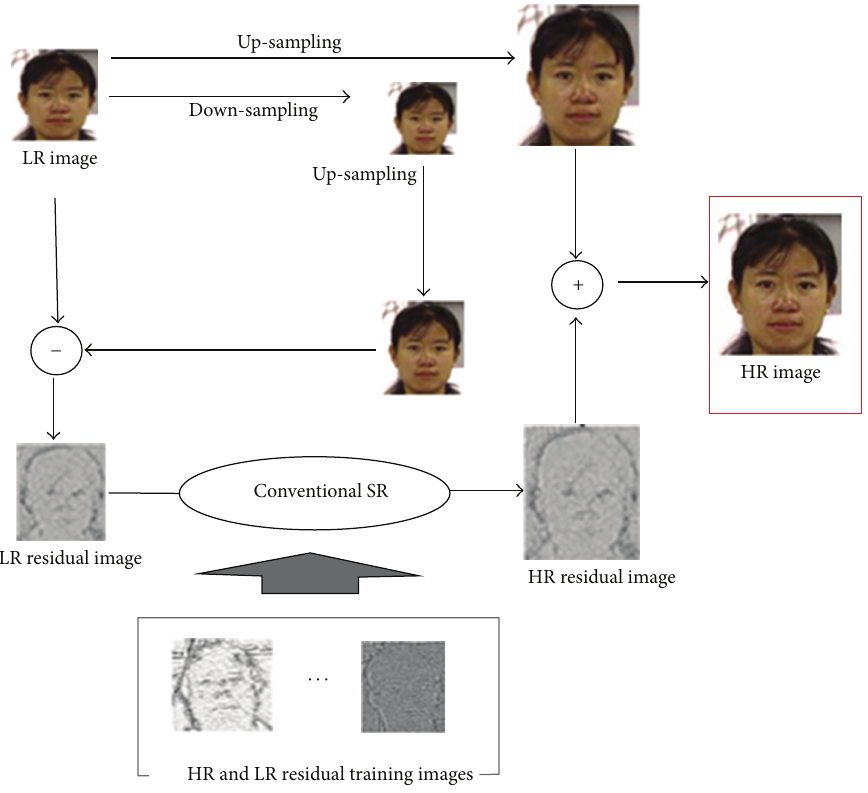
Figure 3: Proposed super resolution method